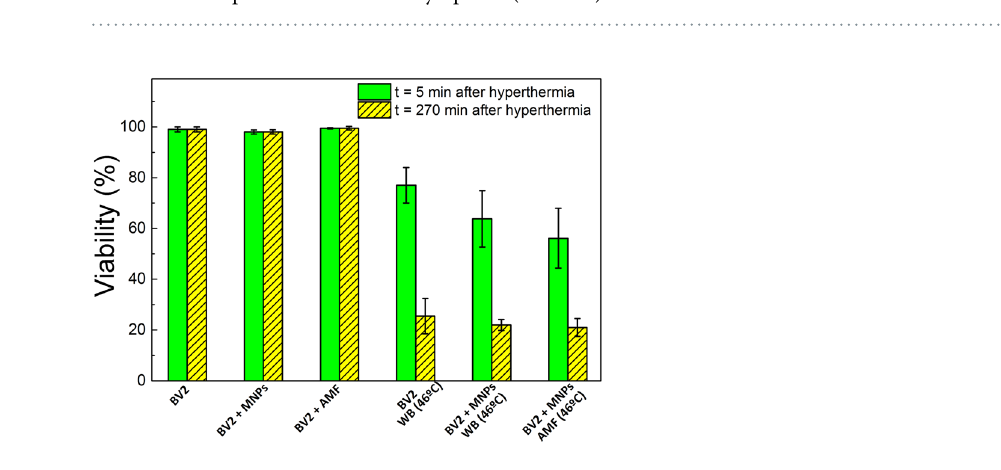
Figure 7. BV2 viability results (n = 3) after water bath and magnetic hyperthermia. Viability was measured 5 min (filled bars) and 4.5 h (dashed bars) after hyperthermia at 46 °C for 30 min. Magnetic hyperthermia experiments were performed at f = 560 kHz and H 0 = 23.9